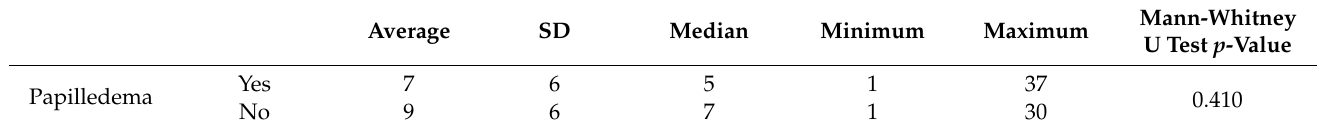
Table 5. Comparison of the presence of papilledema according to the duration of the symptoms in weeks.